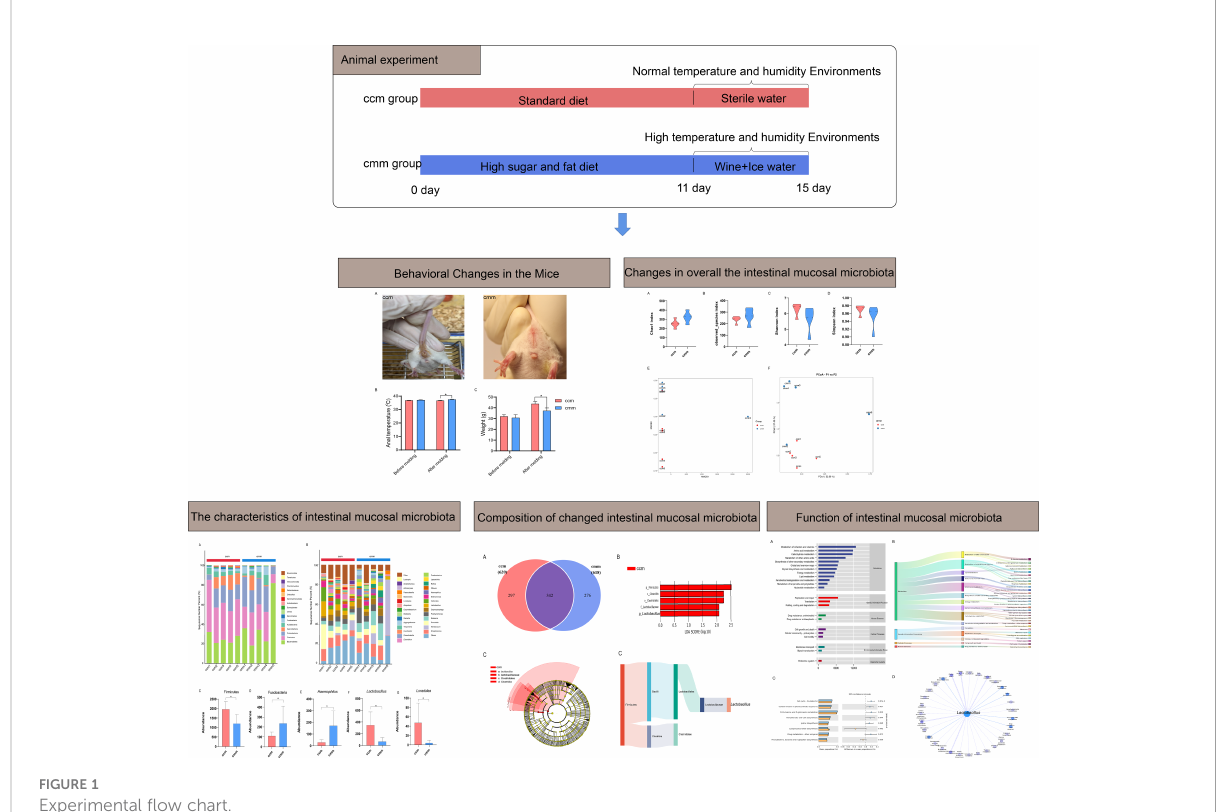
FIGURE 1 Experimental fl ow